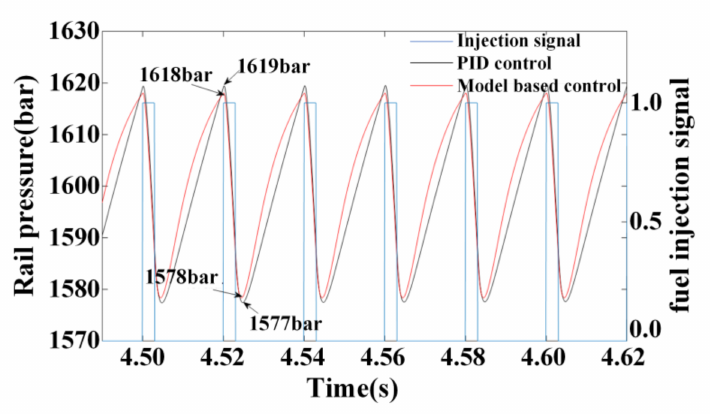
Figure 20. Maintain rail pressure at 1600